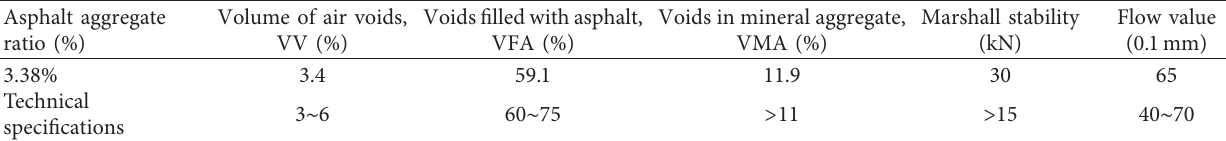
Table 2: Marshall test results and technical specifications for LSAM-30.